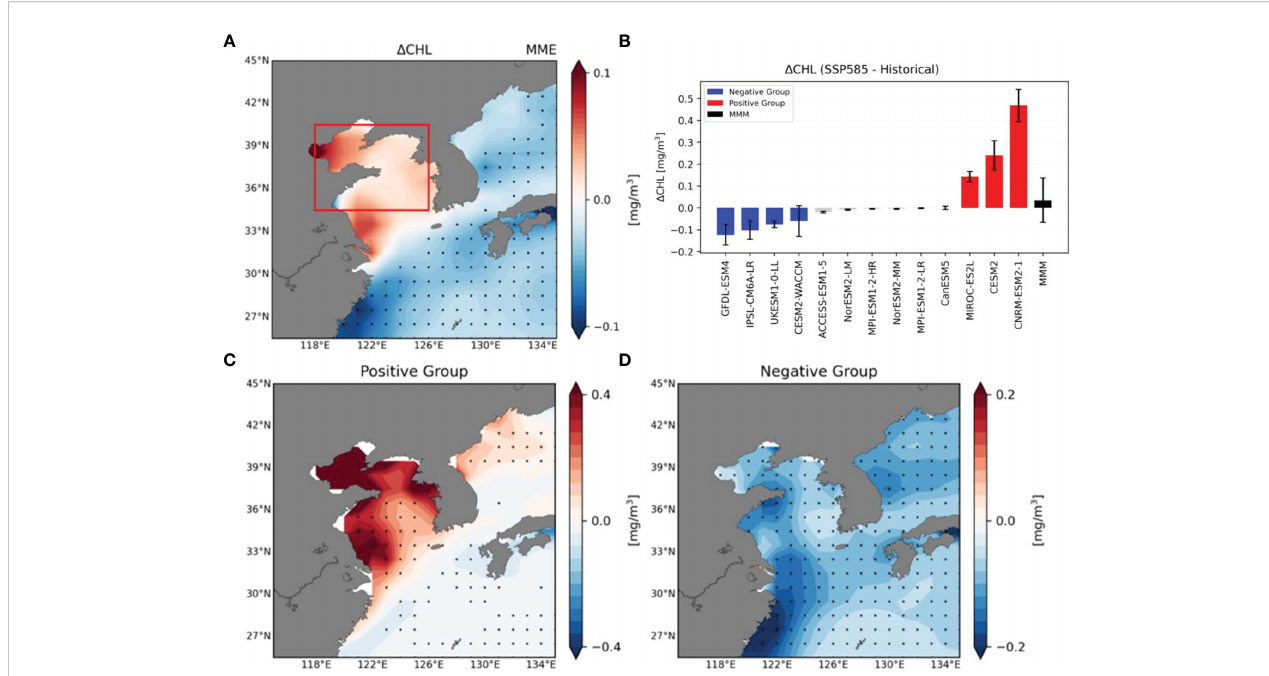
FIGURE 1 (A) Spatial distribution of Multi-Model Ensemble Mean difference in surface (upper 30 m depth mean) chlorophyll-a (SCHL) concentrations between historical climate period (1850 – 2014) and future climate period (2071 – 2100) using 13 CMIP6 models. (B) Area-averaged (Red box in Figure 1A) future changes of SCHL concentrations in the Yellow and East China Sea (YECS) region (34.5°N – 40.5°N, 118°E – 126°E) using 13 CMIP6 models. Red bars indicate models with an increase in SCHL concentrations in the future climate (positive group), and blue bars indicate models with decreasing SCHL concentrations (negative group). The black bar represents the Multi-Model Ensemble Mean (MMM) of 13 models of future change in the SCHL concentrations and crosses represent signi fi cance at the 95% con fi dence levels. (C, D) Spatial distribution of ensemble mean SCHL differences for historical and future climate periods for the positive group and negative group, respectively. Black dots indicate points at which these differences are signi fi cant at the 95% con fi dence level using the bootstrap